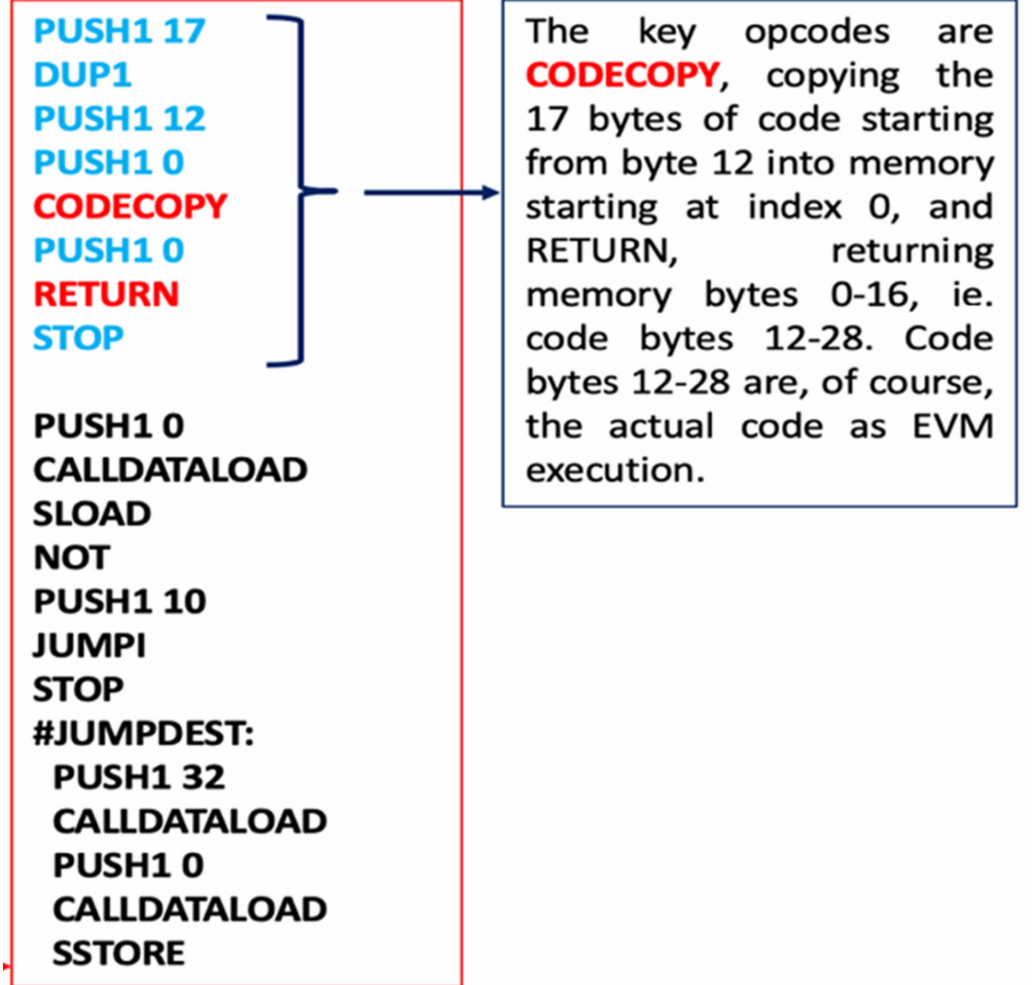
Figure 12. Ethereum Virtual Machine execution of the smart contract bytecode for deploying into the blockchain.